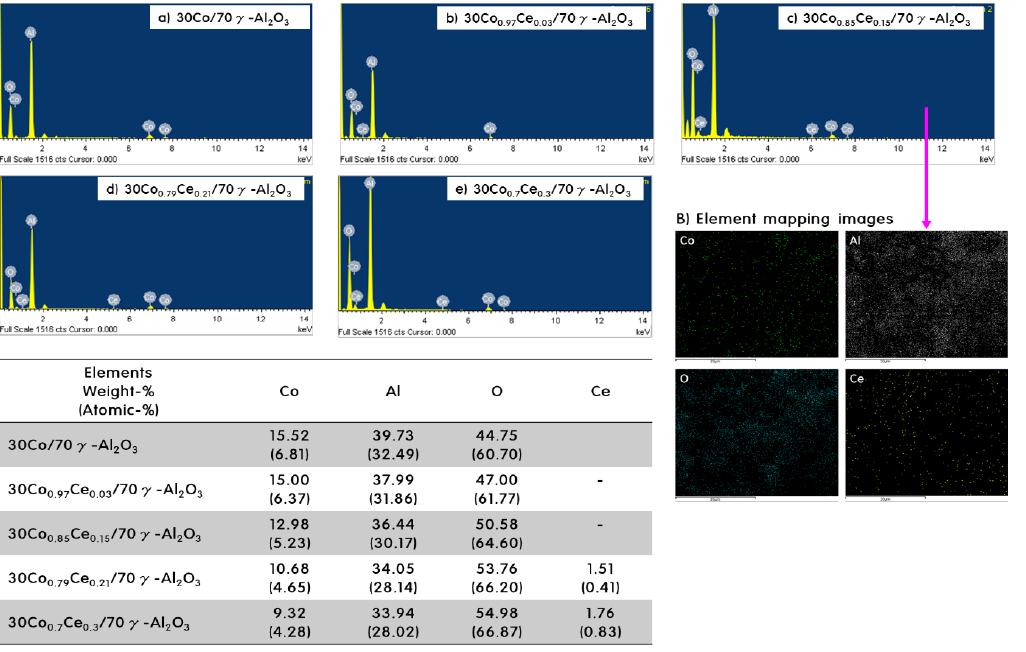
Figure 2. EDS spectra and atomic compositions ( A ) of all catalysts and mapping images for elements ( B ) present in the 30Co 0.85 Ce 0.15 /70 γ -Al 2 O 3 catalyst.